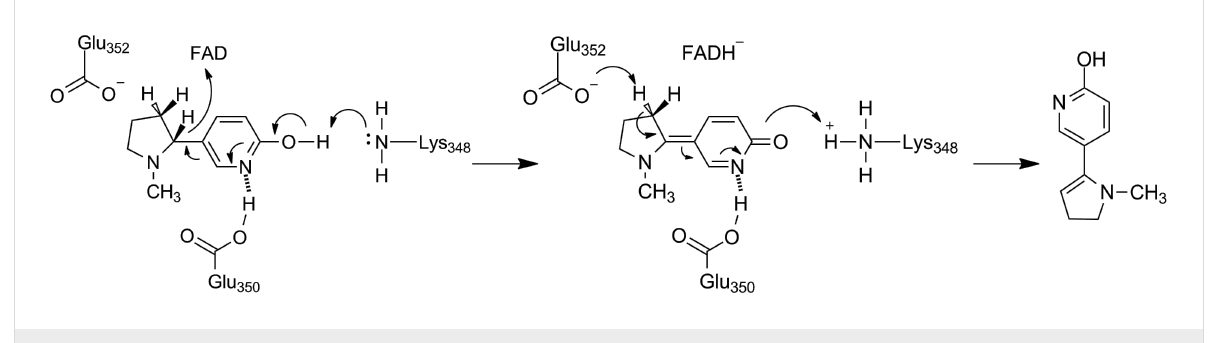
Scheme 5: Proposed mechanism for DHNO [27].